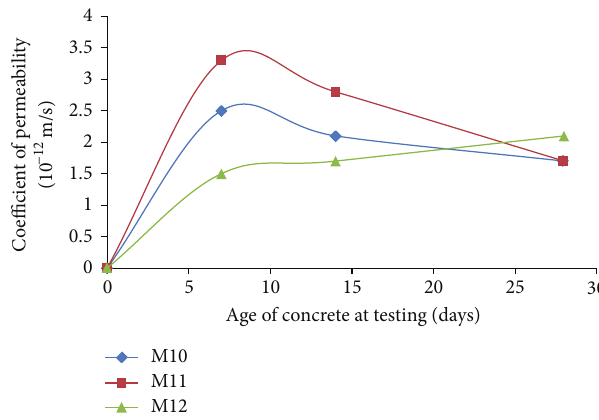
Figure 5: Effect of river sand on the cracked permeability of concrete at 300 kg/m 3 of cement.